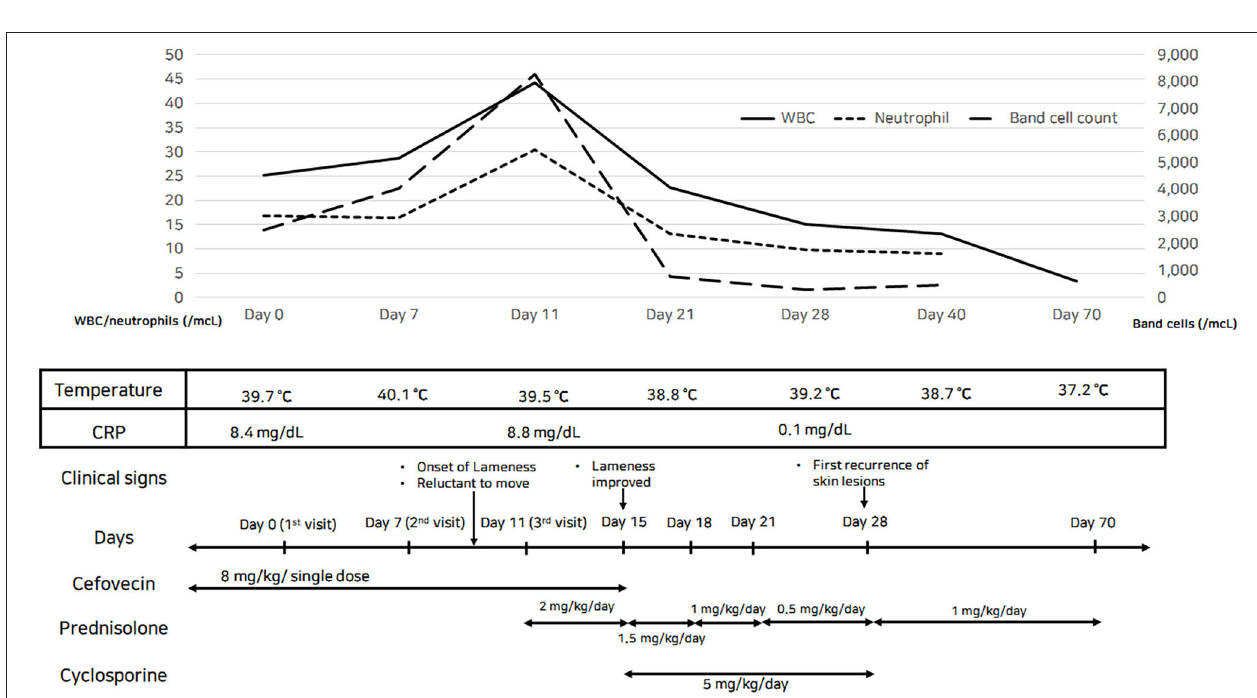
FIGURE 2 | Joint swelling (arrow) of the left carpal joint. Gross image (A) and radiography (B) . Cytology of the synovial fluid showed predominantly non-degenerate neutrophils without infectious agents on synovial fluid cytology (C) .